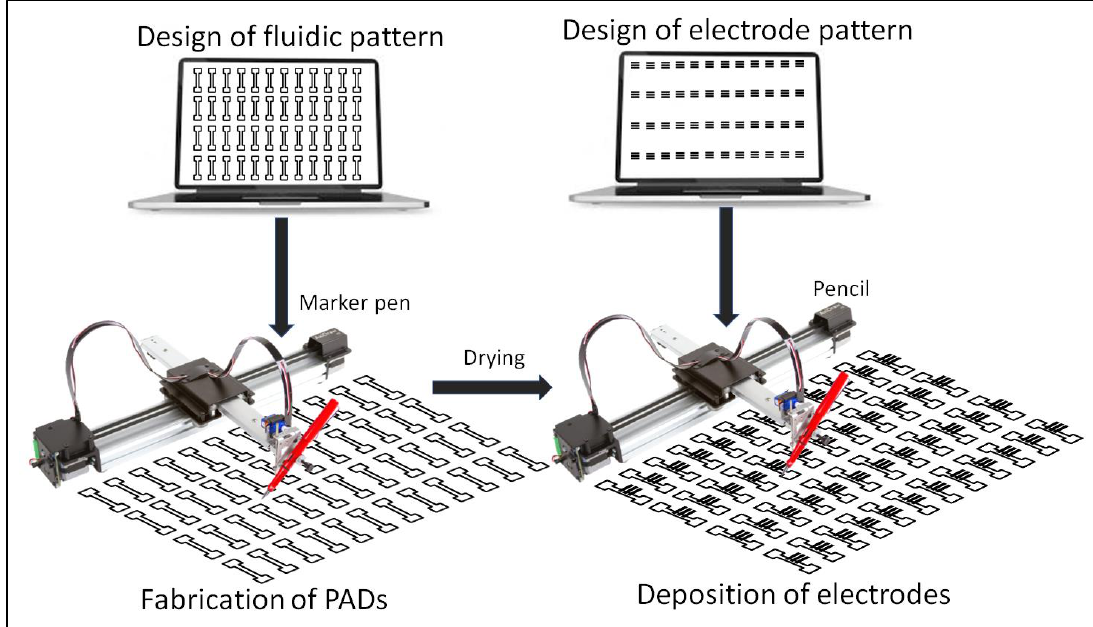
Figure 1. Schematic illustration of the fabrication of the fluidic PADs used in this work.